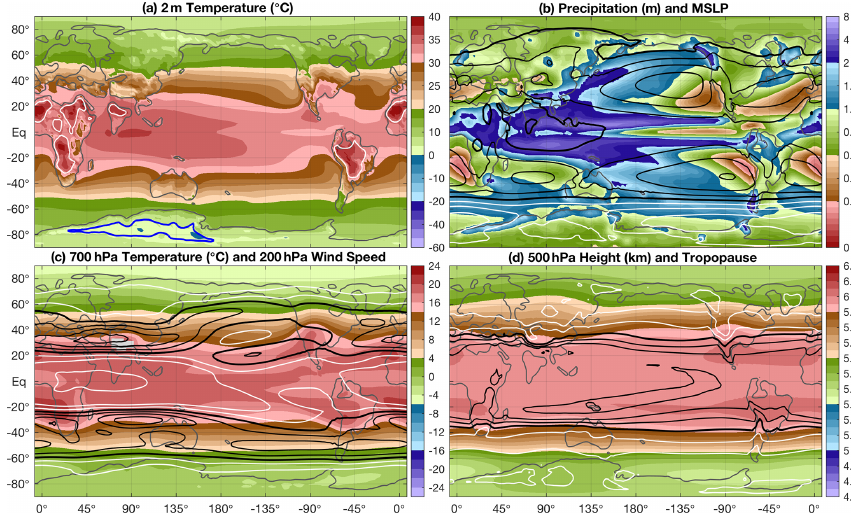
Figure 4. Annual mean for the 38Ma 4 × PIC simulation with (a) near-surface (2m) air temperature (shading) and min–max temperature (contours; blue for T min < 0 ◦ C and white for T max > 40 ◦ C), (b) precipitation (shading) and mean sea level pressure (MSLP; contours every 5hPa, thick black lines every 20hPa, ≥ 1000hPa in black and < 1000hPa in white), (c) 700hPa temperature (shading) and 200hPa wind speed (contours every 5ms − 1 starting at 10ms − 1 ; white for < 20ms − 1 and black for ≥ 20ms − 1 , thick black lines every 20ms − 1 ), and (d) 500hPa geopotential height (shading) and tropopause height (contours every 1km; white for < 15km and black for ≥ 15km, thick black line at